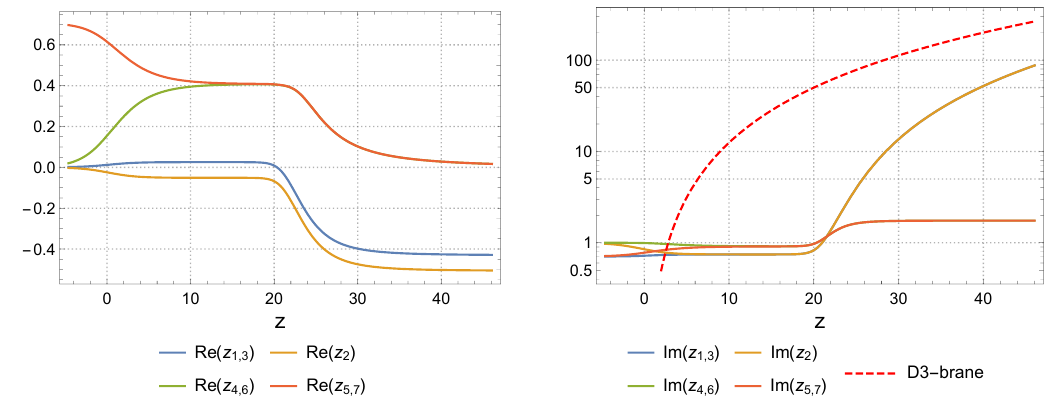
Figure 11 . Holographic RG flow from N = 1 & SU (2) × U (1) J-fold CFT 3 (UV, right) to N = 2 & SU (2) J-fold CFT (IR, left) with (Λ Λ ) = ( − 1 , 0) and ( λ ) = (0 . 0364510166 , 0 . 3417265522) . 3 1 , 2 1 , λ 2